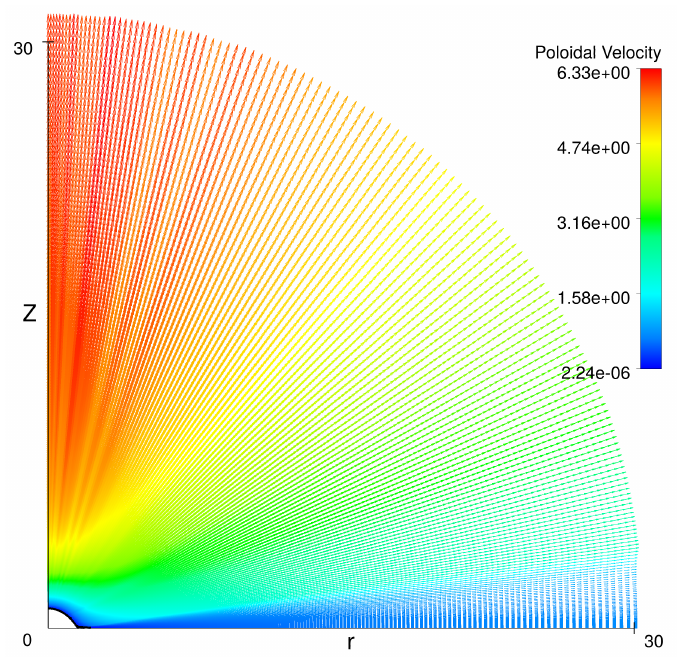
Figure 1. The field of velocity in the poloidal plane at ω = 0.999. Thick black solid line at the star surface—sound line for the poloidal velocity.